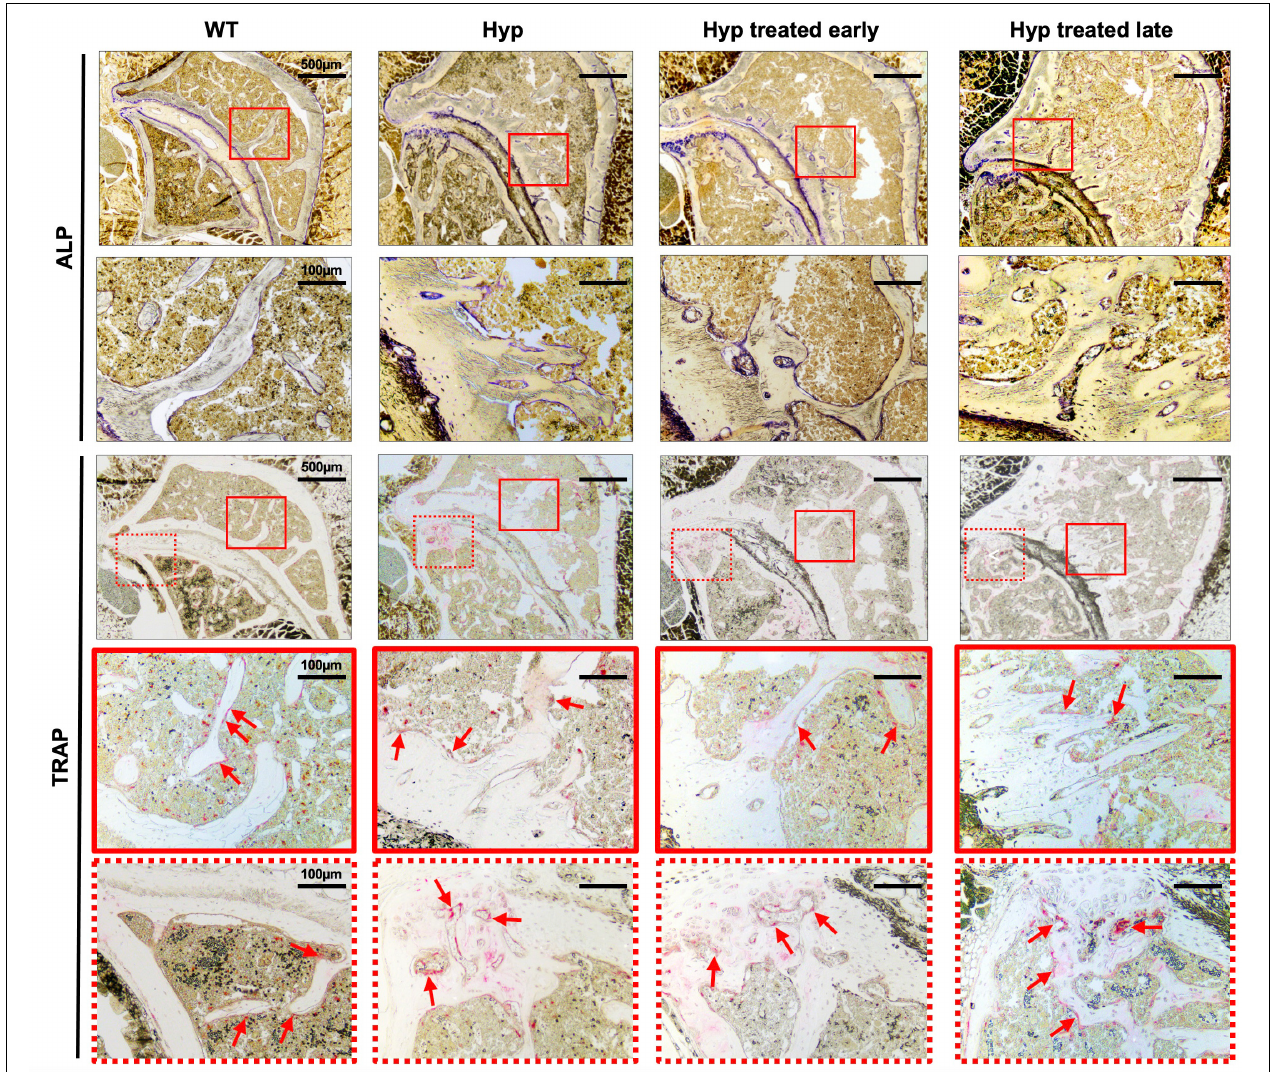
FIGURE 5 | ALP and TRAP enzyme histochemistry of sacroiliac joint of 3-month-old WT mice, untreated Hyp mice, and Hyp mice on conventional treatment started early or late. The TRAP reaction stained for osteoclast cell activity and the osteogenic layer stained with ALP reaction indicate that both early and late start of conventional treatment in Hyp mice hardly changed ALP/TRAP activity. ALP, alkaline phosphatase; TRAP, tartrate-resistant alkaline